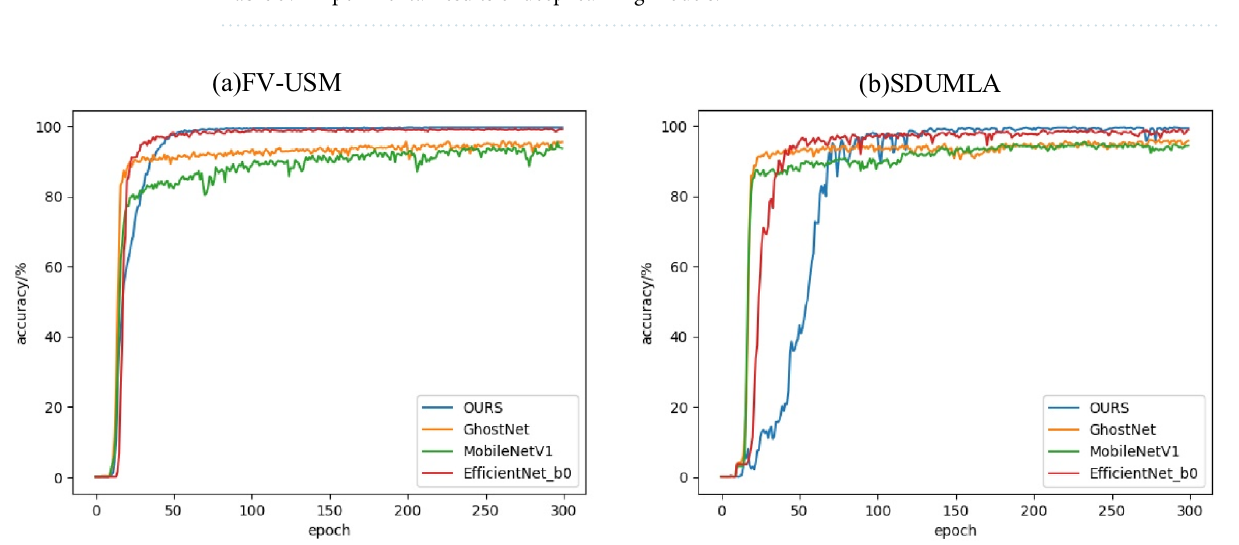
Figure 5. Recognition accuracy